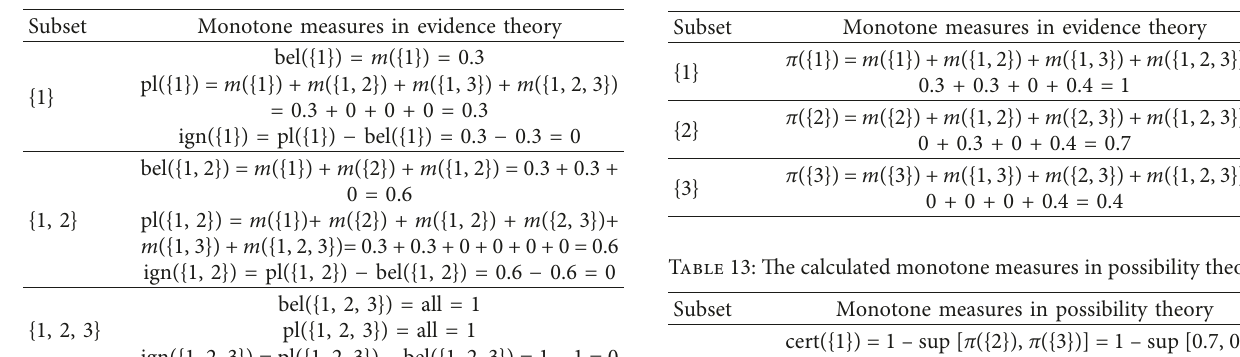
Table 10: The calculated monotone measures in a special case of evidence theory which is the same with probability theory.